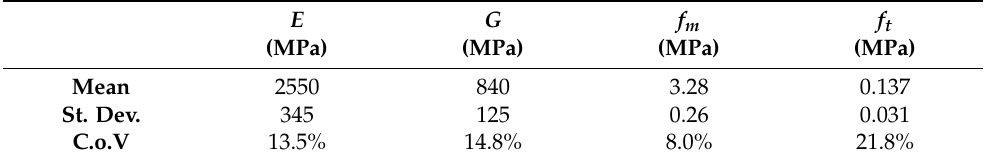
Table 1. Masonry mechanical properties after characterization tests.